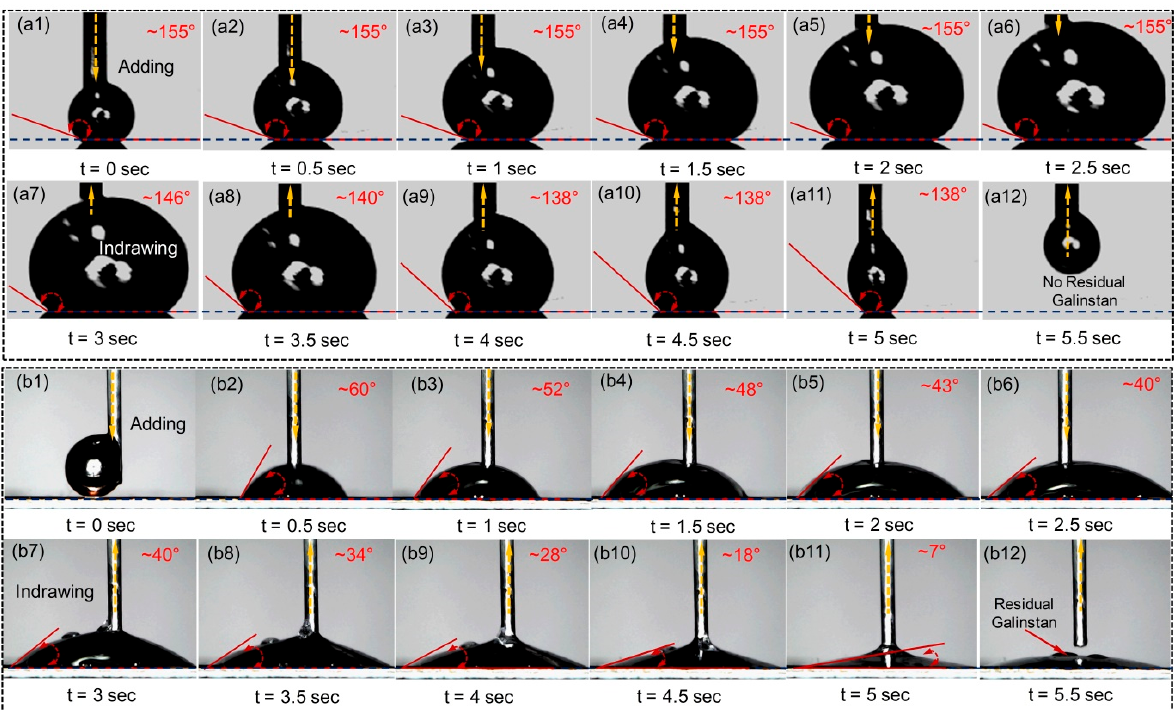
Figure 4. Photographs of advancing and receding angles of the RGD on ( a ) PDMS and ( b ) Au substrate.